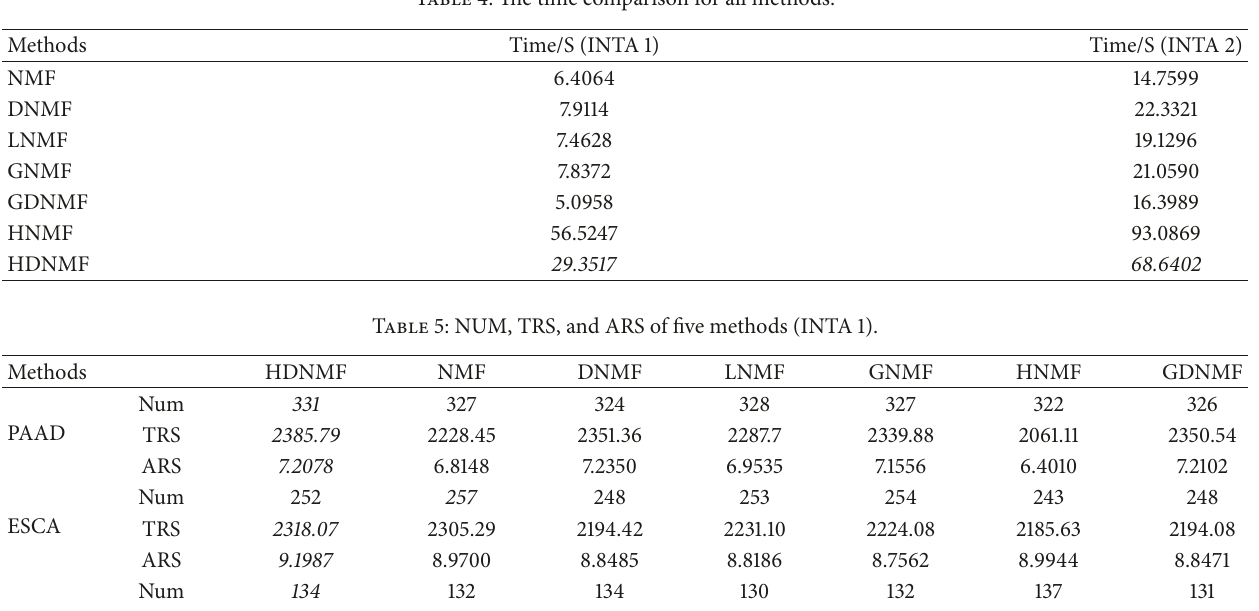
Table 4: The time comparison for all methods.